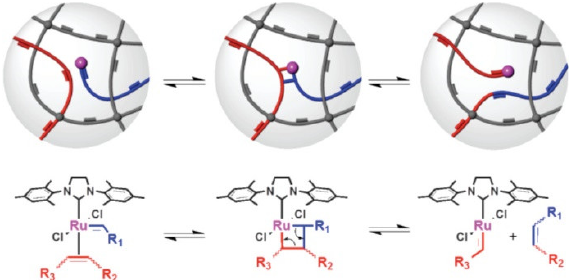
Figure 8. Vinyl urethane vitrimers exhibiting a dual temperature reaction based on two concomi- tant exchange mechanisms: the iminium type in the lower temperature range with an energy bar- rier of E a 60–70 kJ/mol and the Michael reaction type at higher temperatures with a higher E a of 130–170 kJ/ mol. Reprinted with permission from [117]. Copyright (2018) American Chemical So- ciety.